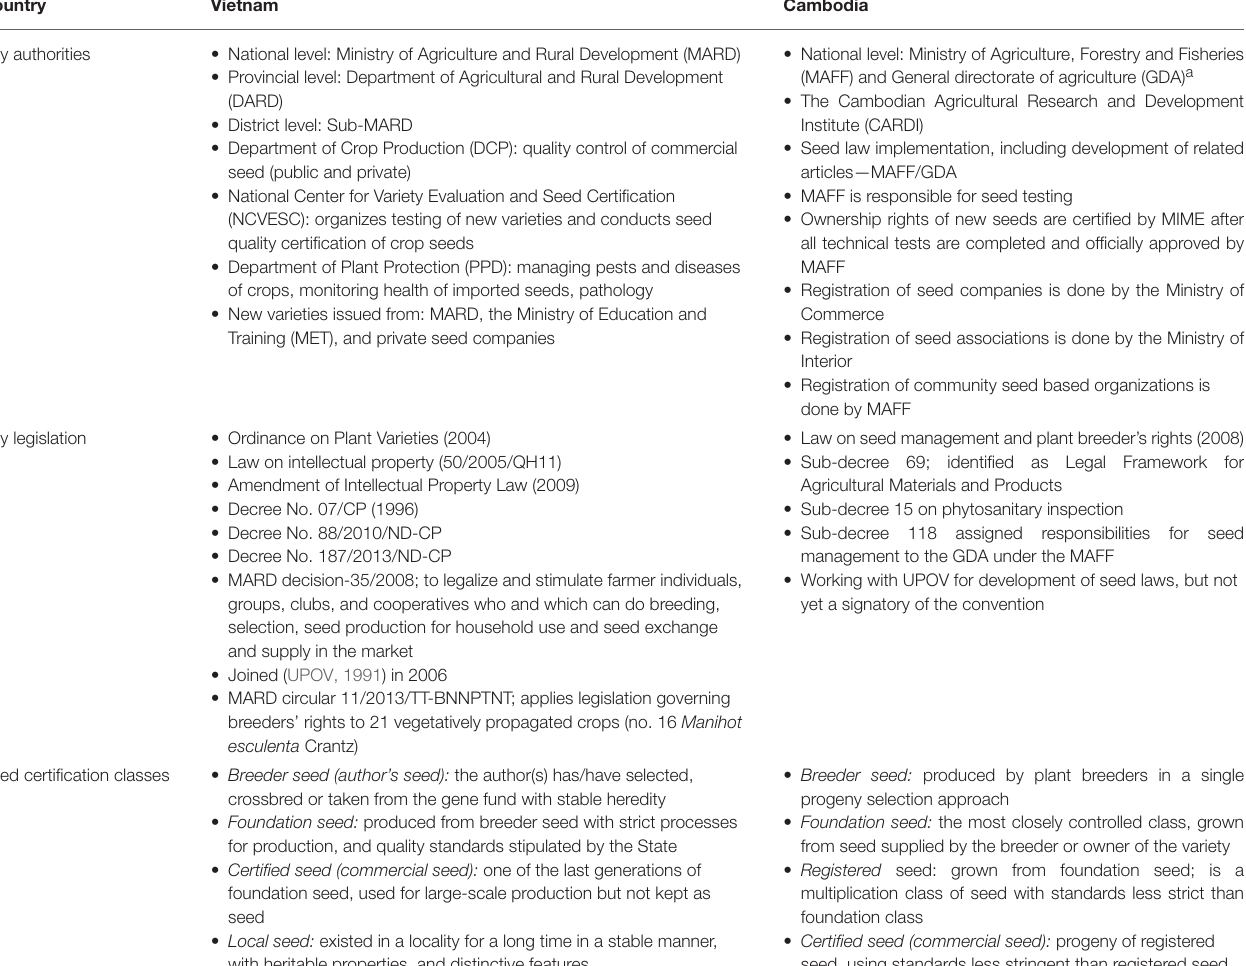
TABLE 7 | Summary of seed policy frameworks of Vietnam and Cambodia (2017).